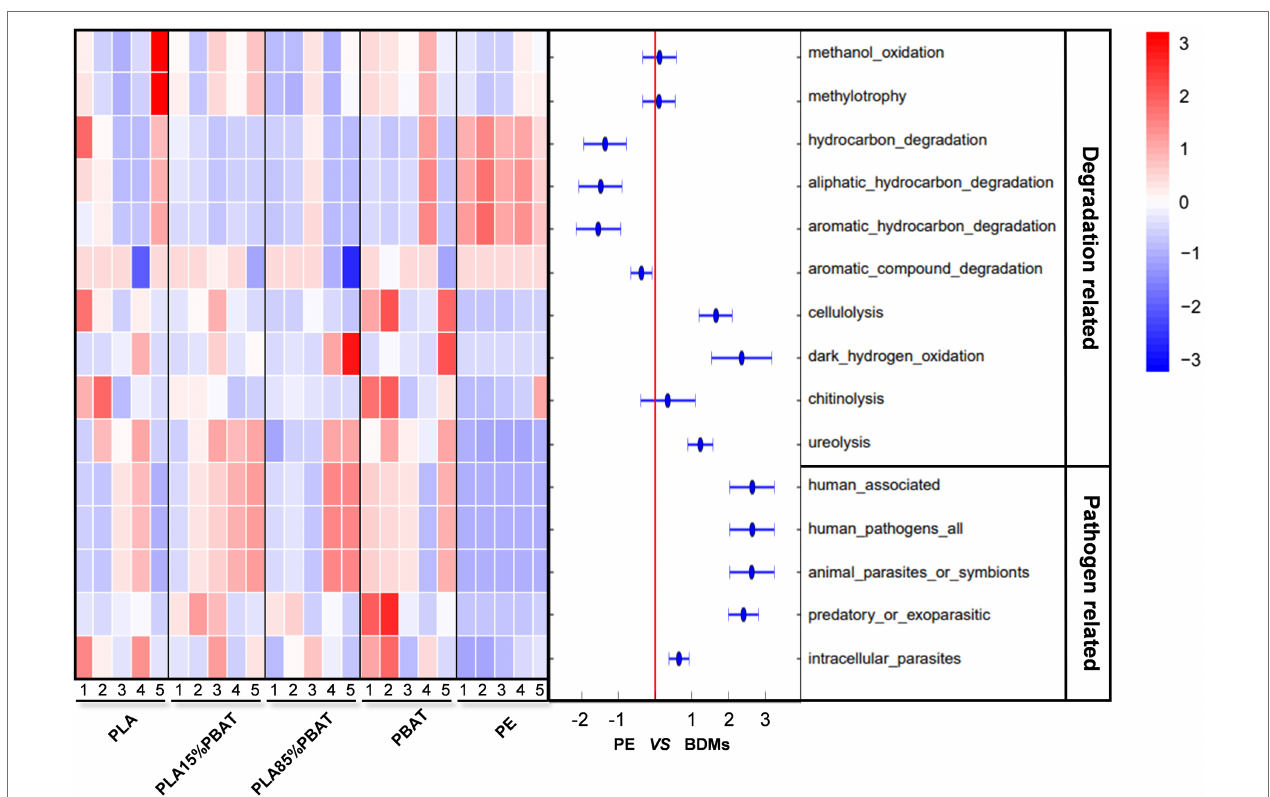
FIGURE 3 | The degradation and pathogen-related functional profiles of four kinds of BDMs and PE. Degradation-related (10 types) and pathogen-related (5 types) functional categories based on FAPROTAX were used to create a temporal heatmap during 5 months and each column of the heat map represents a month. The corresponding results of response ratio at 95% confidence interval between BDMs and PE. The numbers 1–5 represent 5 months,